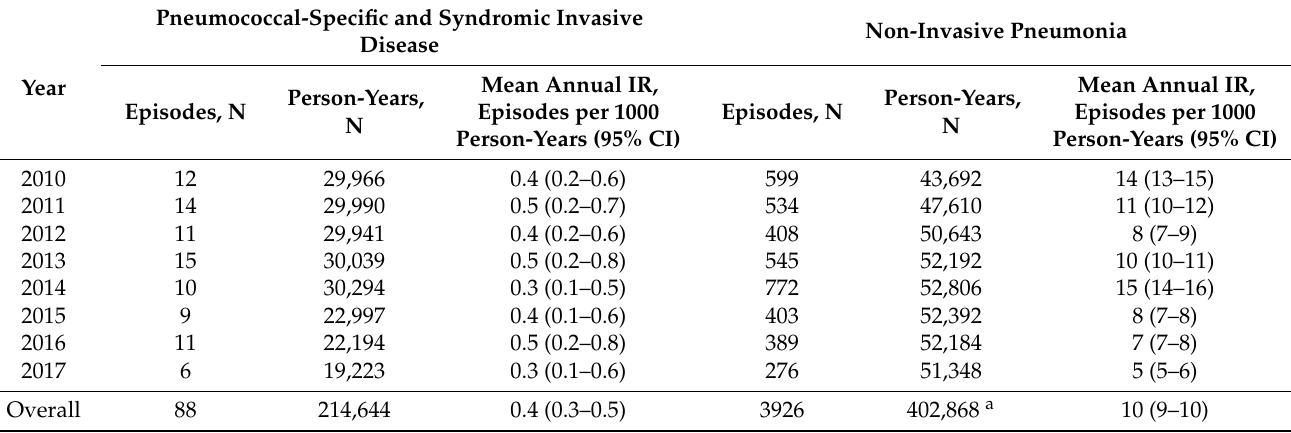
Table 2. Mean annual IR of invasive pneumococcal disease and non-invasive pneumonia in children.